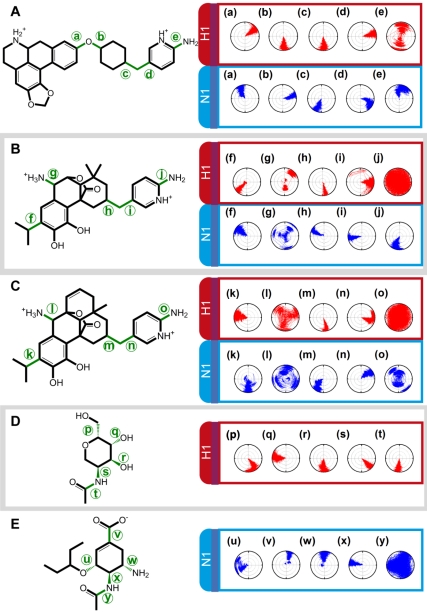
Torsion angles of TCM candidates and Tamiflu in H1 and N1.(A) Xylopine_2, (B) Rosmaricine_14, (C) Rosmaricine_15 and (D) Tamiflu®. Lower case letters specify the bonds on which the torsion angle were monitored.